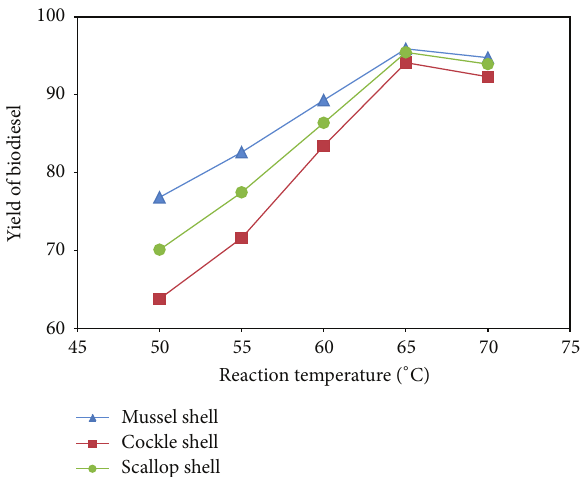
Figure 6: Effect of reaction temperature on % yield of biodiesel. Figure 7: Effect of methanol/oil molar ratio on % yield of biodiesel.